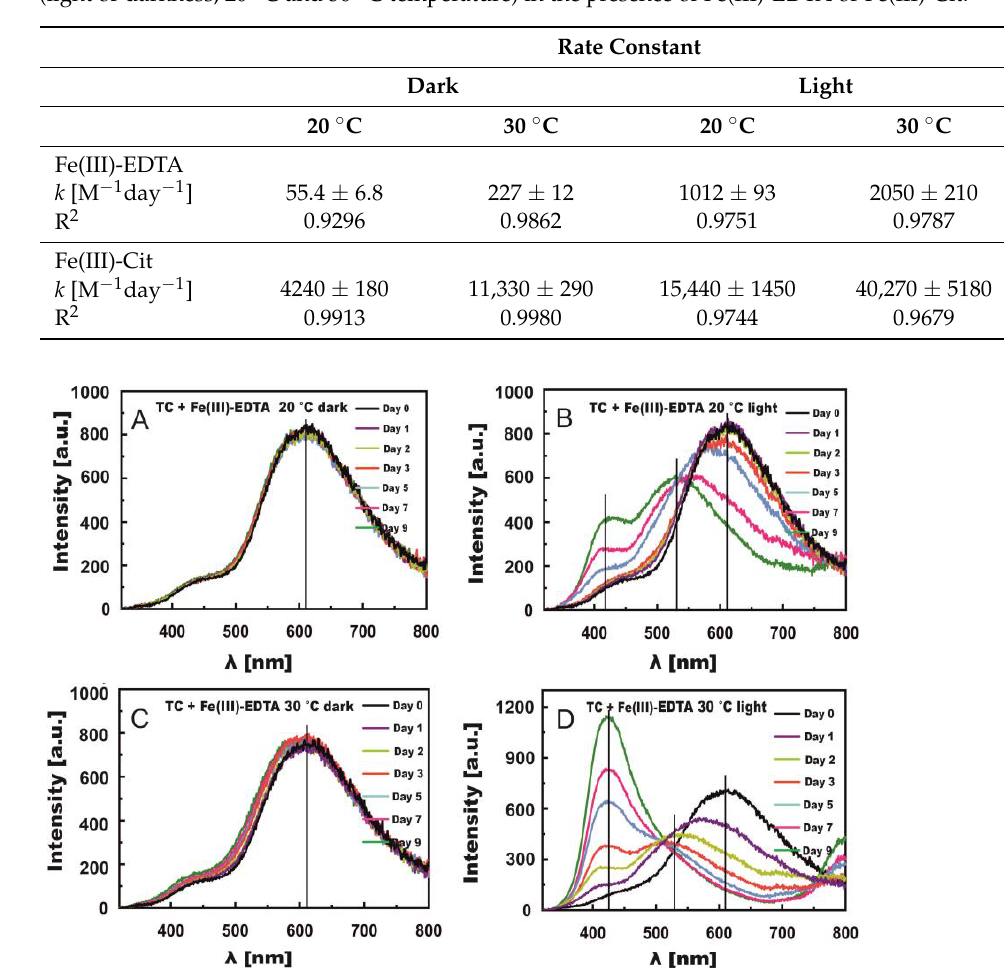
Table 3. The reaction rate constants for TC degradation under different experimental conditions (light or darkness, 20 °C and 30 °C temperature) in the presence of Fe(III)-EDTA or